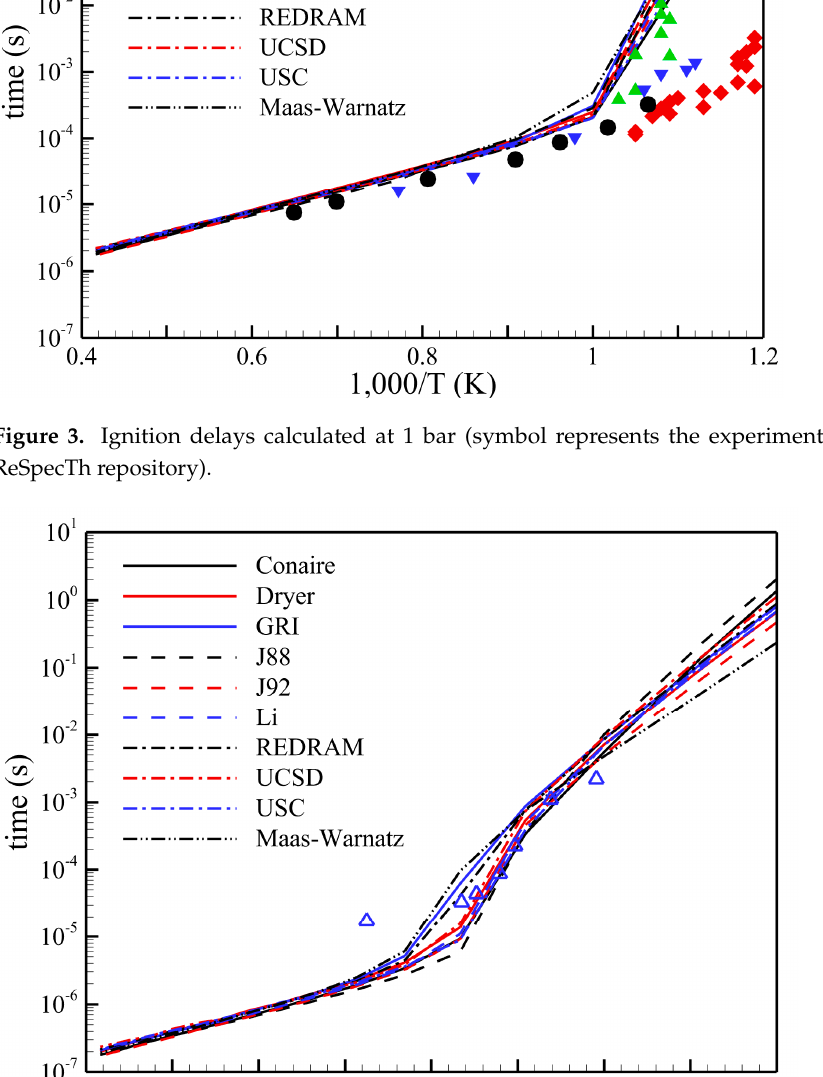
Figure 5. Laminar burning velocity calculated for initial temperature 298 K and 1 bar (symbols rep- resent the experimental results from ReSpecTh repository).